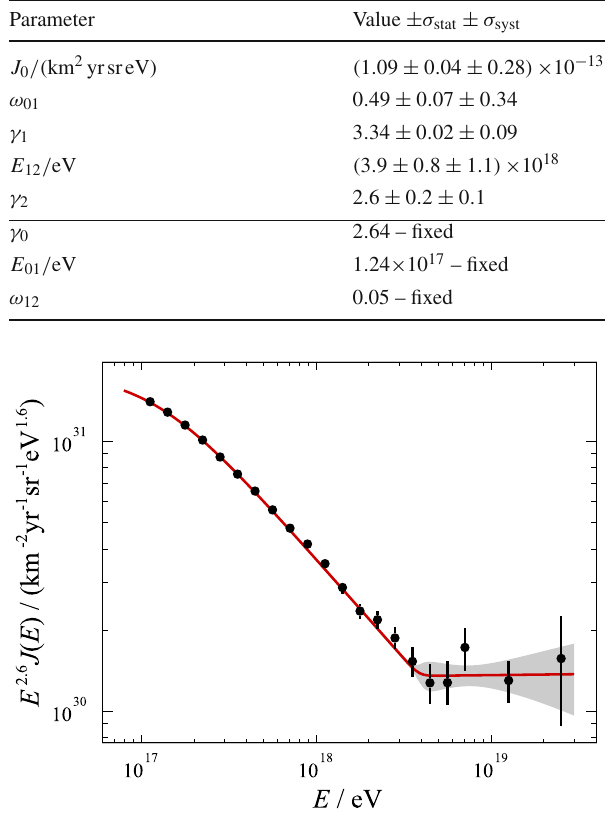
Fig. 13 Unfolded energy spectrum of the SD-750, scaled by E 2 .